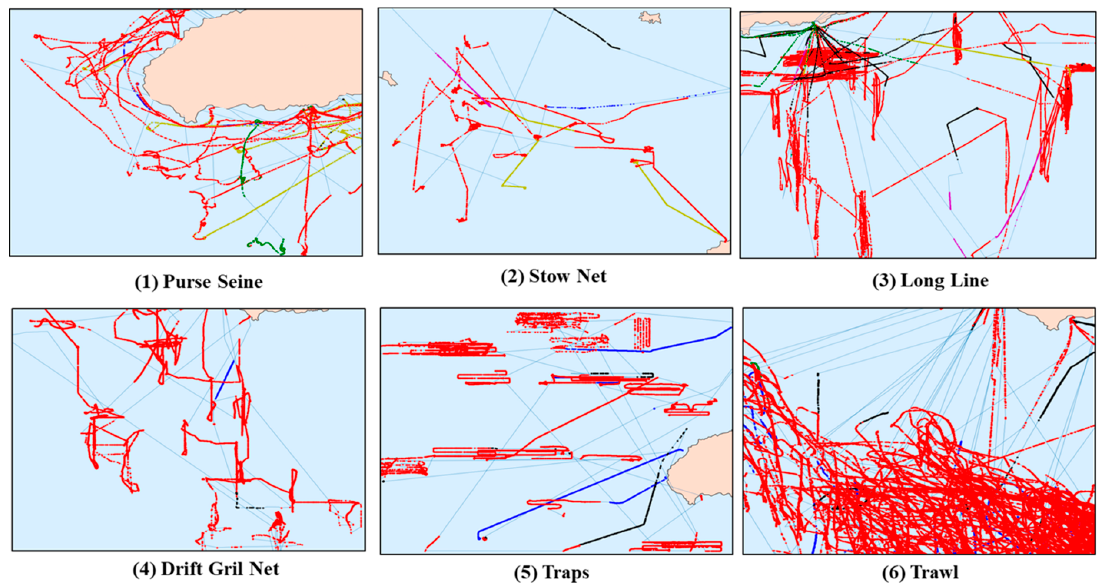
Figure 10. Classification results of the trained model for some trajectory data. The red tracks indicate the correct classification, the sky blue tracks indicate the trajectories of ships with a speed more than 6 knots, and the tracks in other colors indicate false classification for the corresponding sections.